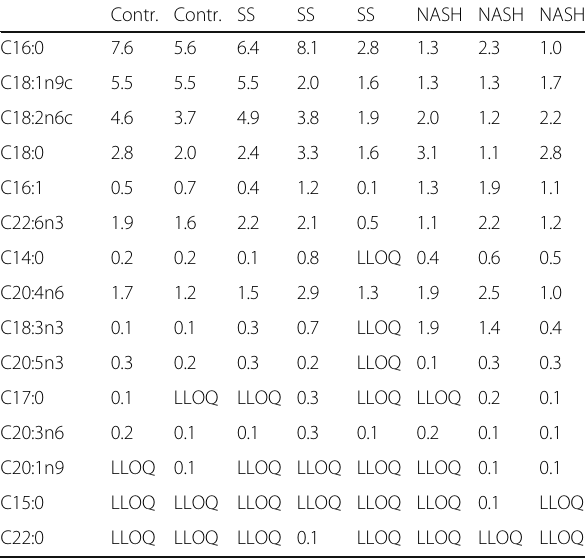
Table 5 Concentration of free fatty acid in human liver sample Contr. Contr. SS SS SS NASH NASH